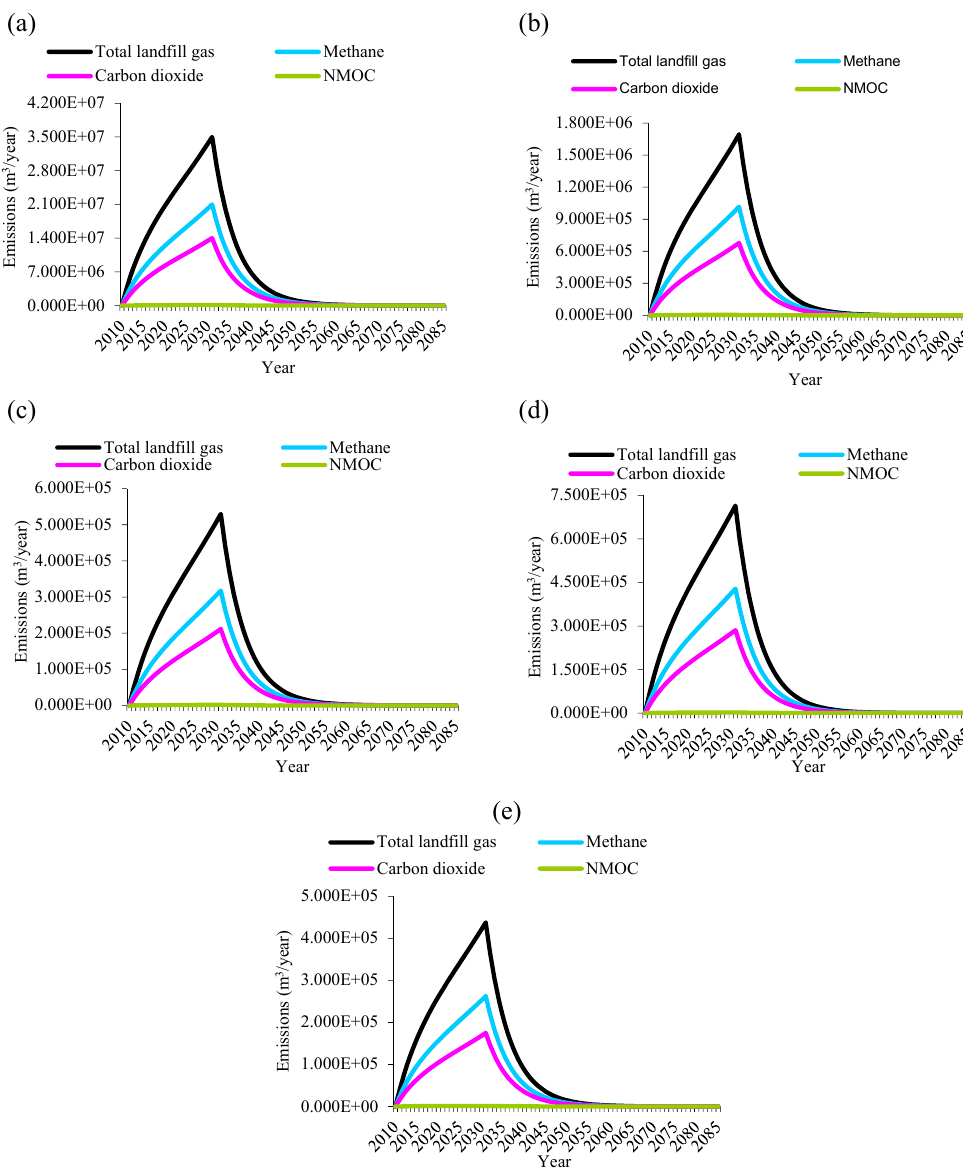
Fig. 4: Potential of gas emission from rapidly degradable organic compounds in (a) Hamedan, (b) Bahar, (c) Joraghan, (d) Lalejin and (e) Marianaj